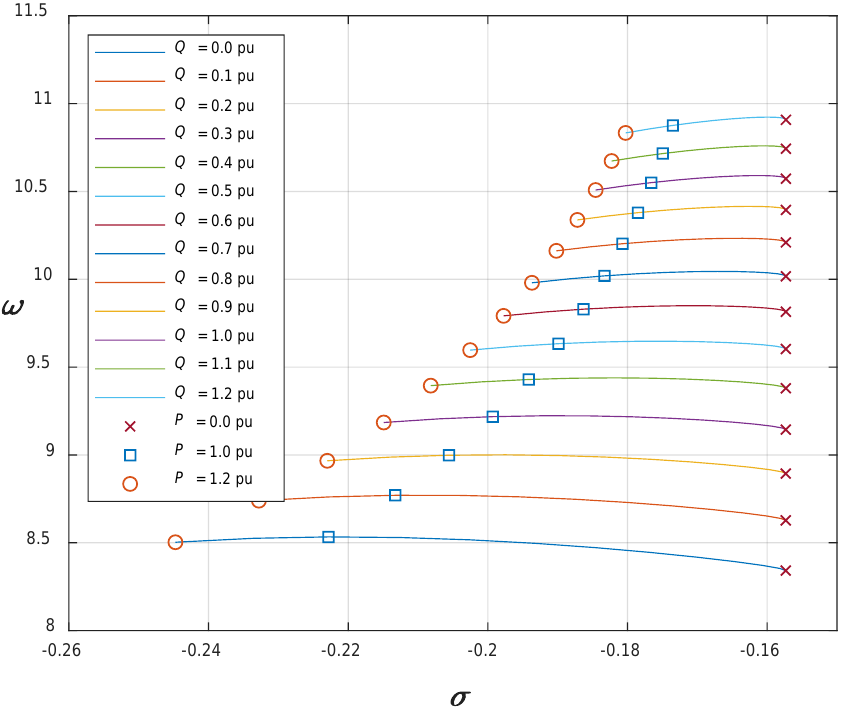
Figure 8. Eigenvalue loci of local mode of a 158-MVA hydro-type synchronous generator where transmission line impedance was reduced to 50% of the nominal (real) impedance (comparable with Figure